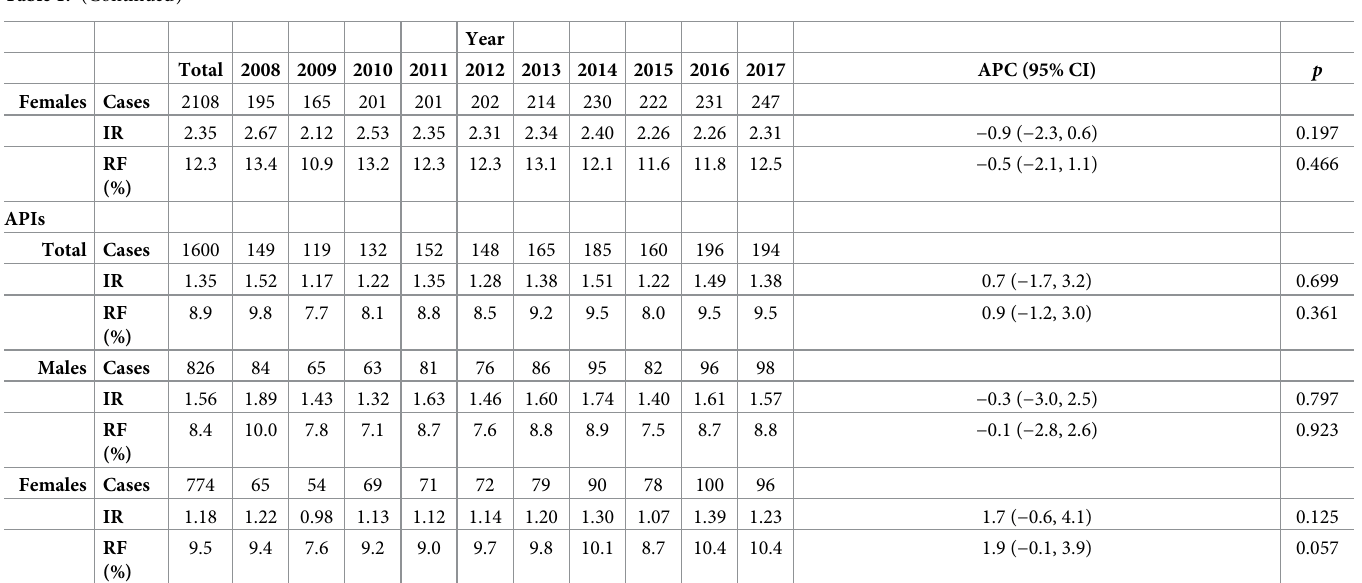
S1 Fig. Trends in the age-standardized incidence rates of follicular lymphoma in Taiwan, Japan, and